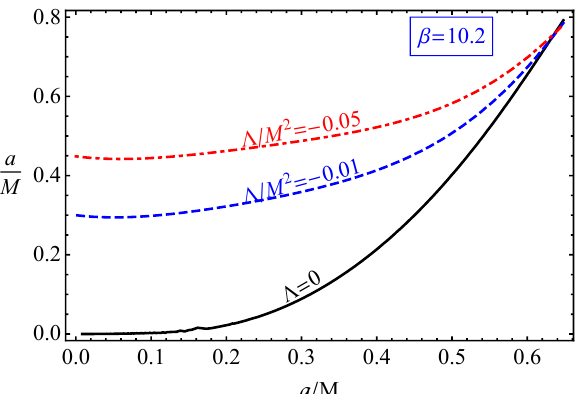
Figure 15. Relations between the magnetic charge of a regular Bardeen black hole in Anti-de Sitter spacetime and the spin of the Kerr black hole, which provides the same value for the ISCO location of the magnetized particle with the parameter β = 10.2 at the different values of the cosmological